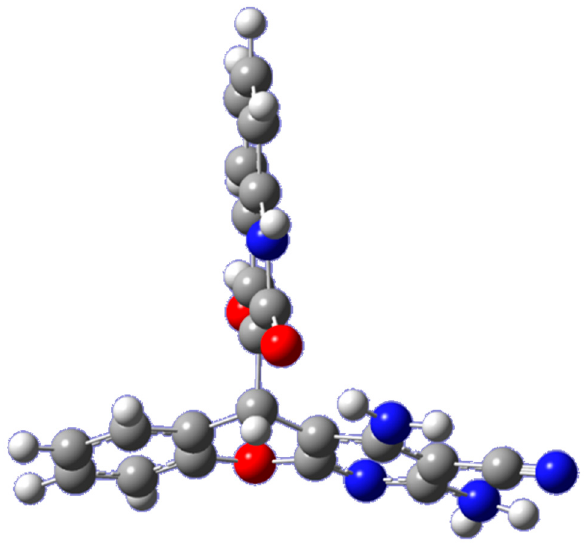
Figure 4. Optimized structure for compound 4a (gas phase).